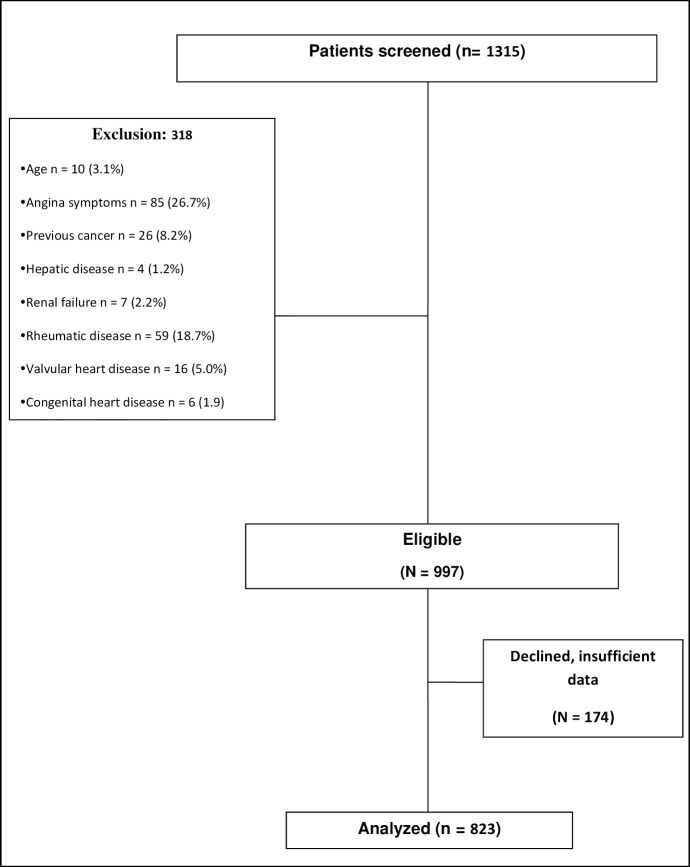
Flow diagram of the study population.